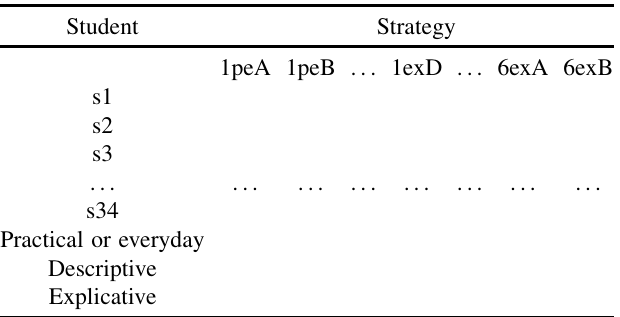
TABLE III. Data matrix for CHIC analysis. The 34 students are indicated as s1, s2, . . . , s34. The three ideal student profiles are described as practical or everyday, descriptive, and explicative, respectively, and the 61 answering strategies are represented